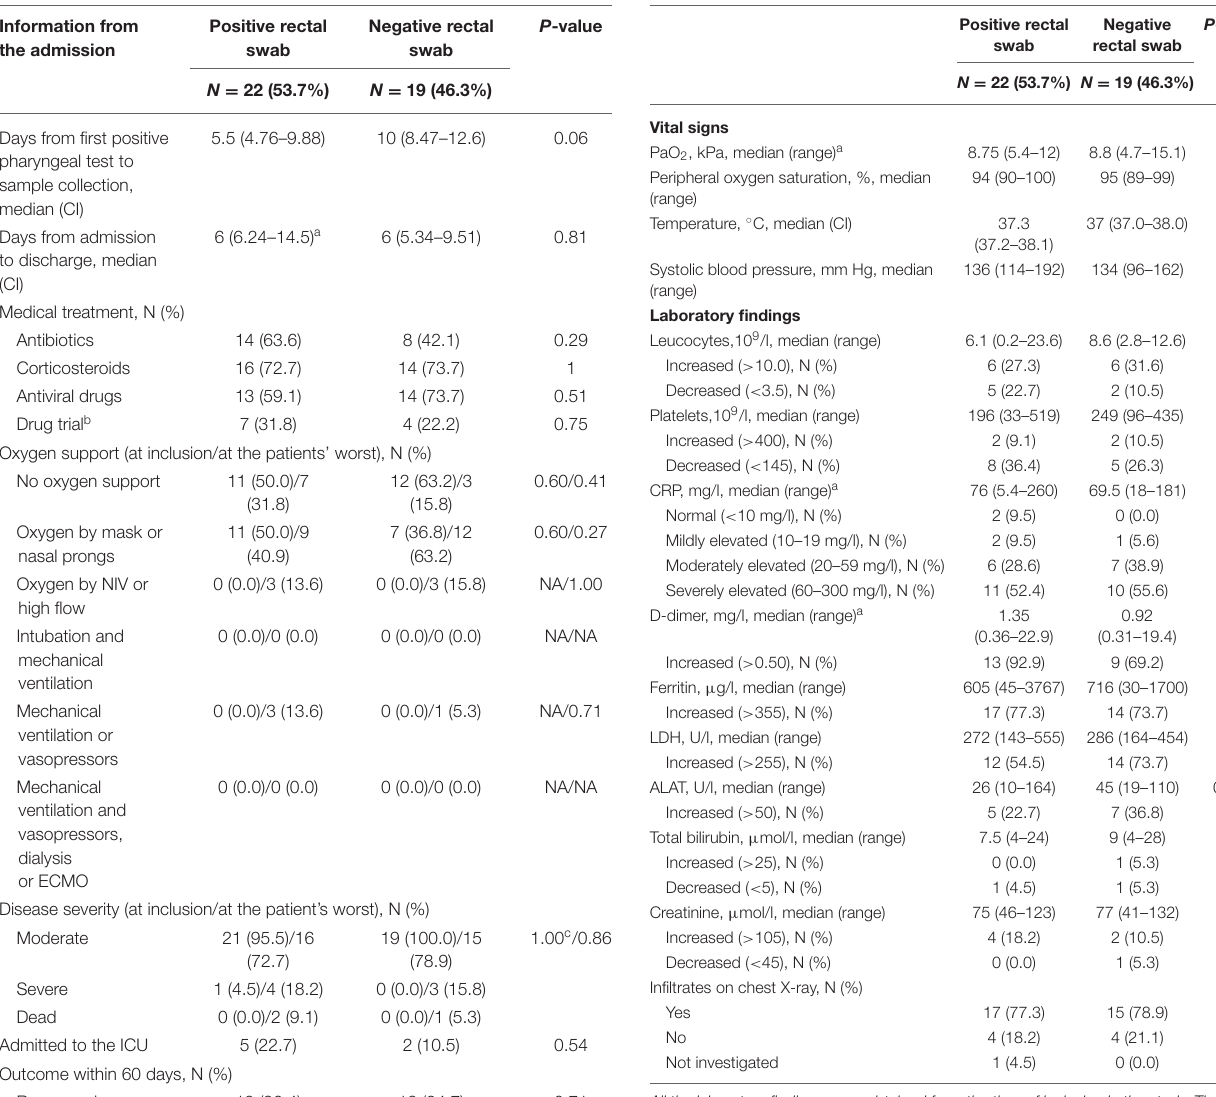
TABLE 4 | Vital signs, laboratory findings, and radiologic findings of hospitalized COVID-19 adult patients with positive and negative rectal swabs,